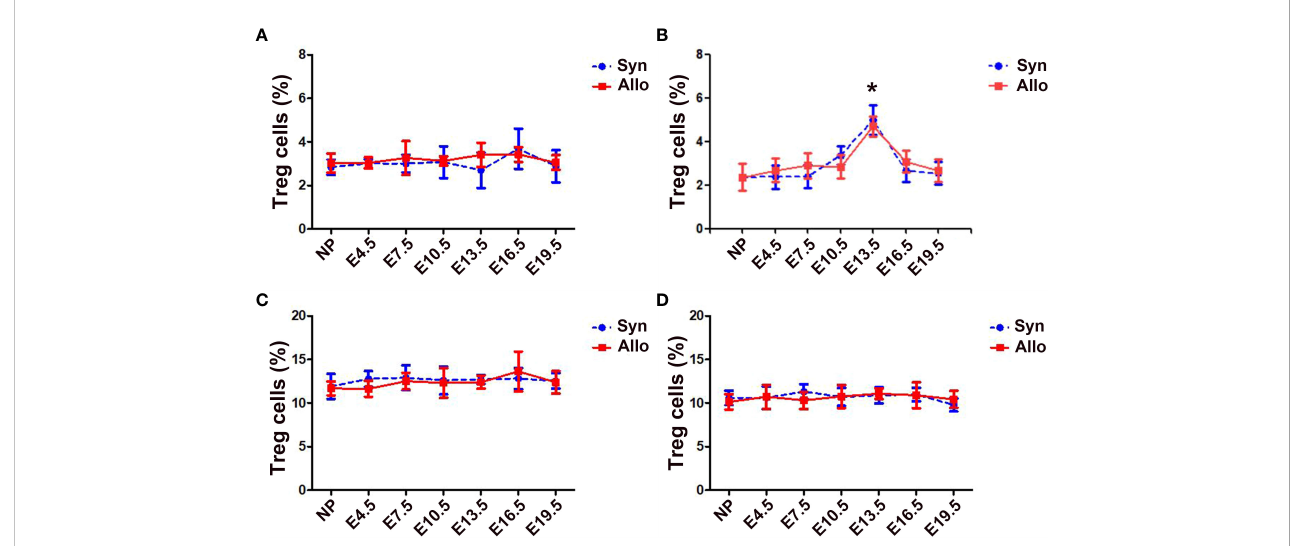
FIGURE 1 Percentages of thymus, blood, spleen and LN Treg cells in syngeneic and allogeneic pregnancies. A graphical summary of the percentages of thymus (A) , blood (B) , spleen (C) and LN (D) Treg cells is presented. Data are presented as mean ± SD (n = 6). * p < 0.01 vs the non-pregnant mice. NP, non- pregnant group; Syn, syngeneic pregnant group; Allo, allogeneic pregnant